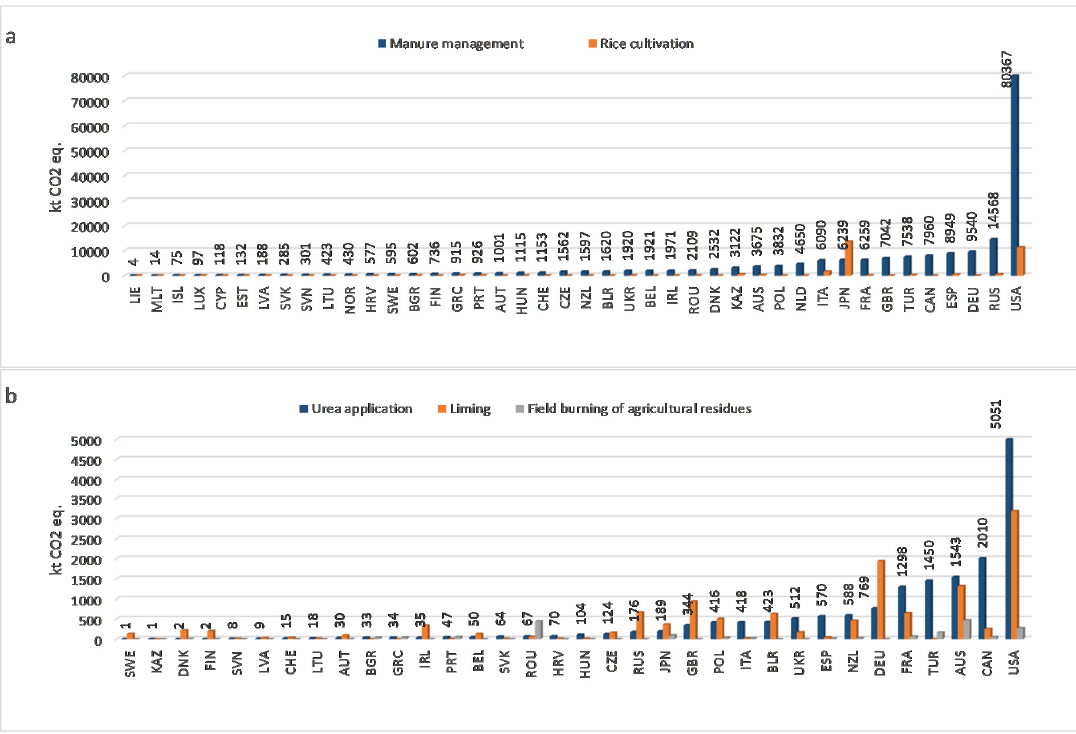
Figure 5. The emissions from manure management and rice cultivation ( a ), and urea application, liming and field burning of agricultural residues ( b ). Numbers indicate the amount of GHGs manure management ( a ) and urea application ( b ).